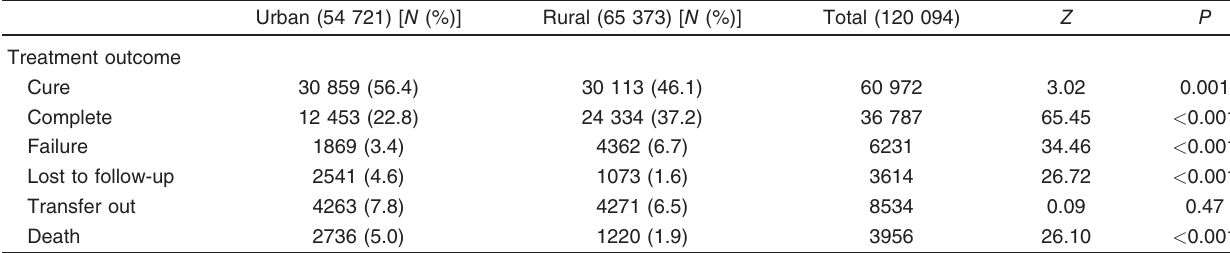
Table 4 Treatment outcome in urban and rural